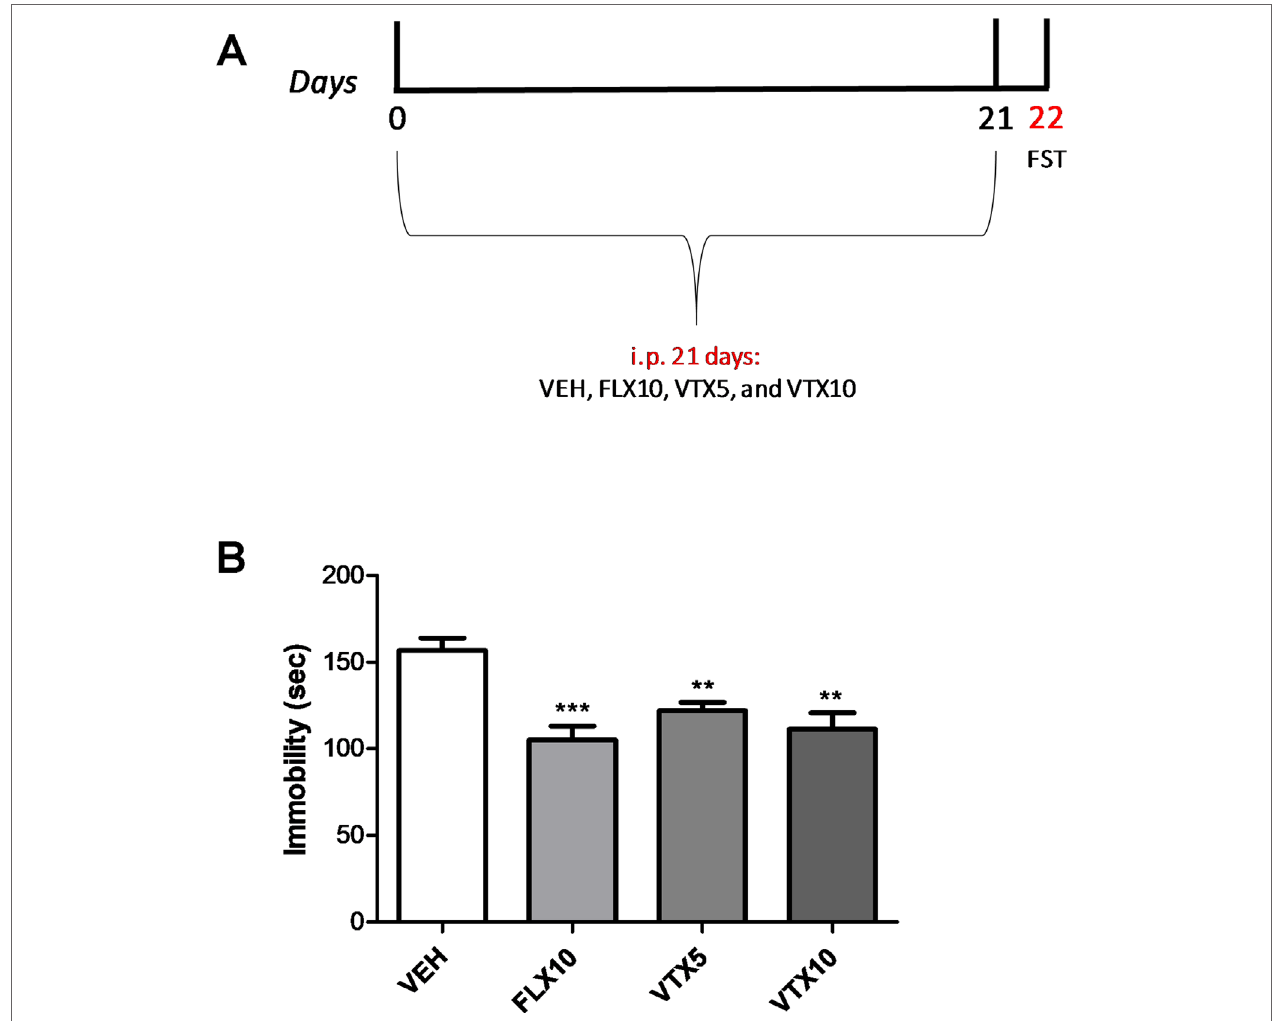
FIGURE 1 | Vortioxetine decreases depressive-like behavior in a concentration-dependent manner. Forced swim test (FST), carried out to evaluate the depressive- like behavior, was performed the day after the last injection. VEH = vehicle (i.p.), FLX10 = fluoxetine 10 mg/kg, (i.p.), VTX5 = vortioxetine 5 mg/kg (i.p.), and VTX10 = vortioxetine 10 mg/kg (i.p.) were administered chronically for 21 days. i.p. = intraperitoneal injection. (A) Schematic representation of the experimental design. (B) Immobility time displayed by groups treated with FLX10 ( n = 9), VTX5 ( n = 10), and VTX10 ( n = 7) was significantly reduced if compared with that of vehicle-treated group ( n = 9) over a 4-min test period. Immobility time measures are expressed in seconds. Data are shown as mean ± SEM. ** p < 0.01, *** p < 0.001 vs. VEH; ANOVA among all: F (3,31) =